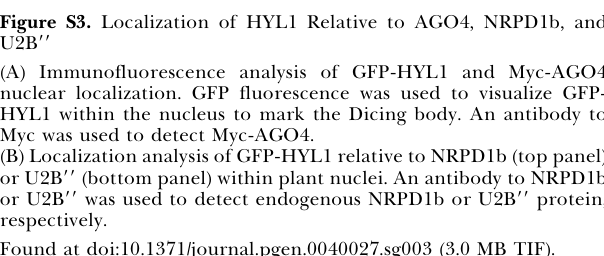
(B) Average intensity measurements for AGO4, NRPD1b, and DAPI at the two different AGO4 bodies. Fifteen nuclei containing AGO4/ NRPD1b or AGO4/Cajal bodies were used for the averaging. Figure S3. Localization of HYL1 Relative to AGO4, NRPD1b, and U2B 99 (A) Immunofluorescence analysis of GFP-HYL1 and Myc-AGO4 nuclear localization. GFP fluorescence was used to visualize GFP- HYL1 within the nucleus to mark the Dicing body. An antibody to Myc was used to detect Myc-AGO4. (B) Localization analysis of GFP-HYL1 relative to NRPD1b (top panel) or U2B 99 (bottom panel) within plant nuclei. An antibody to NRPD1b or U2B 99 was used to detect endogenous NRPD1b or U2B 99 protein, respectively. Found at doi:10.1371/journal.pgen.0040027.sg003 (3.0 MB TIF). Figure S4. U2B 99 Immunostaining in coilin SALK Mutants Nuclei isolated from four SALK lines containing a T-DNA insertion in COILIN were examined for Cajal body formation by U2B 99 immunostaining. No Cajal body was observed in SALK 148589, 148630, and 010395 mutant lines. SALK 083448 is a hypomorphic allele in which a small percentage of nuclei contained a Cajal body. The remaining 2% of nuclei from wild type (Col) did not contain an observable Cajal body by U2B 99 immunostaining. Figure S5. DNA Methylation and siRNA Levels in the coilin Mutants and Overexpressor (A) Southern blot analysis examining DNA methylation at the 5S rDNA repeats. Genomic DNA was digested with methyl-sensitive enzymes Hae III (GG m CC) or Hpa II (C m CGG). The triple DNA methyltransferase mutant drm1 drm2 cmt3 is a control for the loss of DNA methylation. (B) Southern blot analysis examining DNA methylation at MEA-ISR . Genomic DNA was digested with Msp I. The methylated DNA band is labeled ‘‘ M ’’ , and the unmethylated band is labeled ‘‘ U ’’ . (C) Northern blot analysis examining levels of siRNAs corresponding to the 45S and 5S rDNA repeats. The microRNA miR159 was used as a loading control. (D) Southern blot analysis examining 5S rDNA methylation levels in the ncb-1 dcl3 double mutant. Genomic DNA was digested with Hae III. Two independent biological replicates of dcl3 and ncb-1 dcl3 were examined. Figure S6. NRPD2 Nuclear Bodies in Arabidopsis Nuclei Different NRPD2 localization patterns relative to AGO4 within Myc- AGO4 nuclei are shown. The white arrow indicates an AGO4 focus that did not colocalize with NRPD2. The yellow arrow shows an NRPD2 nuclear body that did not colocalize with AGO4. Nuclei containing observable AGO4 or NRPD2 foci were examined. Figure S7. DNaseI Controls for the DNA FISH Experiments Sample slides were treated with DNaseI (7.5 U, Roche) for 30 min at room temperature after primary antibody incubation and postfixing for DNA FISH. DNaseI treated samples did not show hybridization with the 45S rDNA, 5S rDNA, or CEN probe. Found at doi:10.1371/journal.pgen.0040027.sg007 (2.1 MB TIF). Figure S8. Localization of AGO4 or Cajal Body Relative to the NORs (A) 45S rDNA FISH combined with Myc-AGO4 immunofluorescence analysis. Nuclei containing NORs surrounded by two AGO4 foci (top panel) or three AGO4 foci (bottom panel) were observed. The